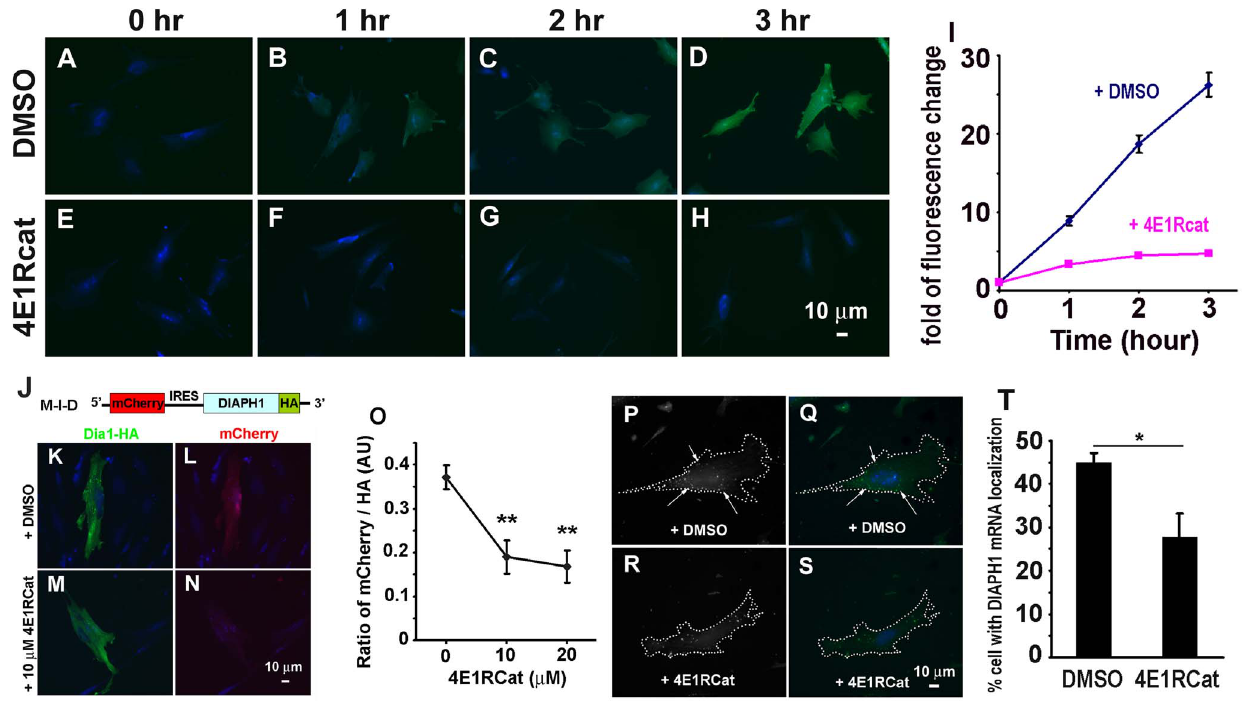
Figure 2. 5 9 -cap-mediated translation is required for perinuclear DIAPH1 mRNA localization. A–H, 4E1RCat inhibits the majority of new protein synthesis (assayed with Click-iT kit, see Materials and methods for details). I . Quantitative results of 4E1RCat inhibition of new protein synthesis. , 120 cells were analyzed for each time point per condition from three independent experiments. J. Illustration of bicistronic expression plasmid M-I-D (for mCherry-IRES-DIAPH1). K–N . 4E1RCat inhibits cap-mediated but not IRES-mediated translation. Representative images show transfected cells treated with DMSO ( K,L ) or 10 m M of 4E1RCat ( M,N ). CEF were first transfected with the bicistronic plasmid for 2 hr and then incubated with DMSO or 10 m M 4E1RCat for 11 hr. The cells were fixed and processed for immunofluorescence staining for the HA tag. Fluorescence images were acquired and quantified. O . Quantitative result of mCherry/HA ratio in single cells. (n=12–24). ** p , 0.01. P–S . Inhibition of cap- mediated translation delocalizes DIAPH1 mRNA. CEF were incubated with DMSO or 10 m M of 4E1RCat in growth medium for 3 hr and then fixed for mRNA detection. P–S , representative cells treated with DMSO or 4E1RCat. Images in left column are gray scale for better display of DIAPH1 mRNA signal. Dotted lines indicate cell border. Arrows indicate localizing DIAPH1 mRNA. In right column, green: DIAPH1 mRNA, blue: nucleus. Note that cells treated with 4E1RCat show diffused DIAPH1 mRNA. Scale bar: 10 m m. T . Quantitative result of endogenous DIAPH1 mRNA localization in treated CEF. 300–500 cells were scored from three independent experiments for each condition. * p ,